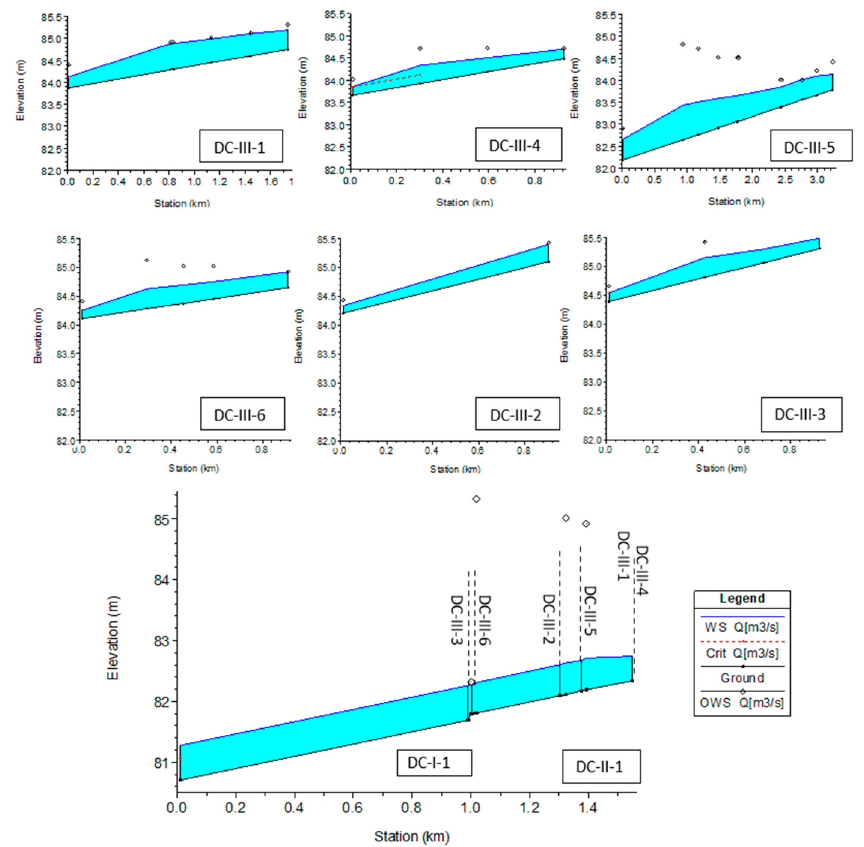
Figure 9. HEC-RAS profile plot of primary, secondary, and tertiary drains with optimization variables (normal depth at confluence and lateral drain height along the canal, diamond symbols). In the profile plot, the observed water levels are indicated using diamond symbols.